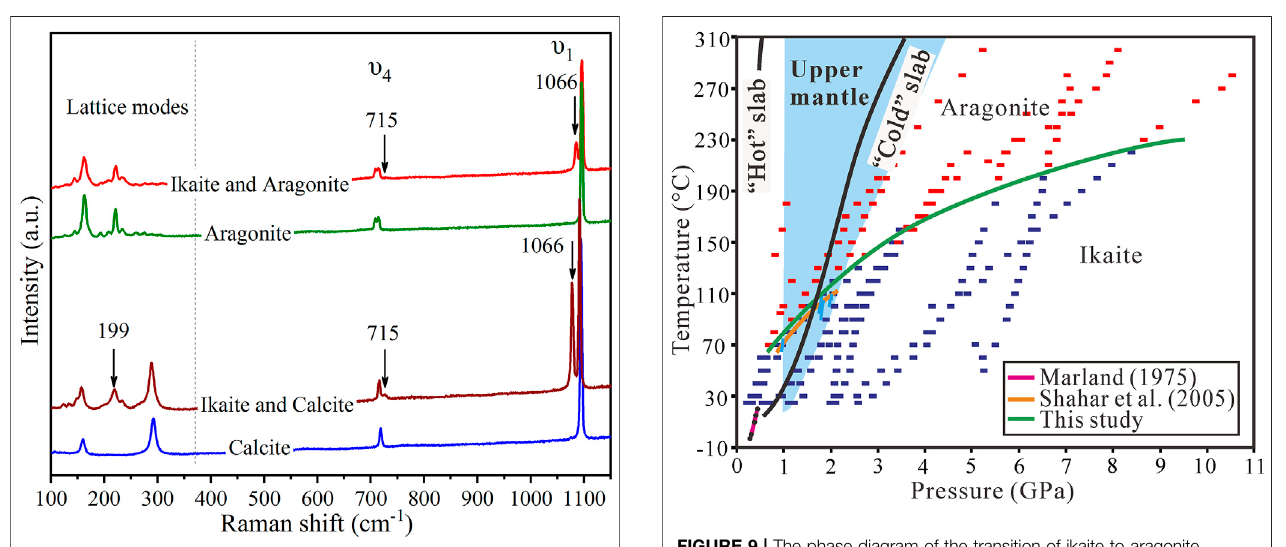
Frontiers in Earth Science |